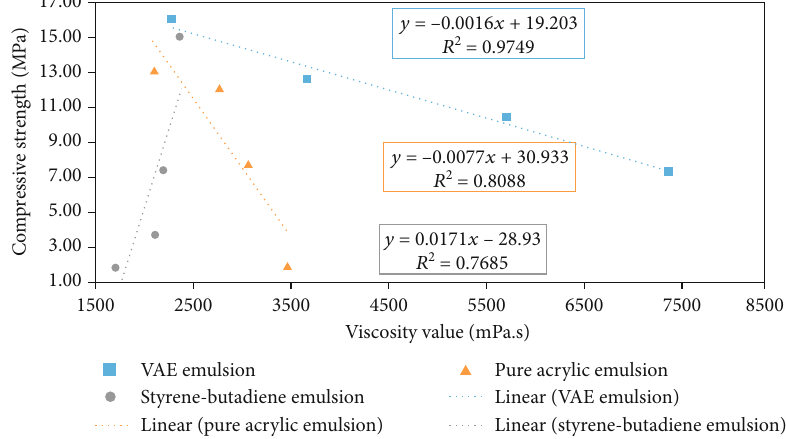
Figure 13: Relationship between viscosity and compressive strength of three TSL materials.